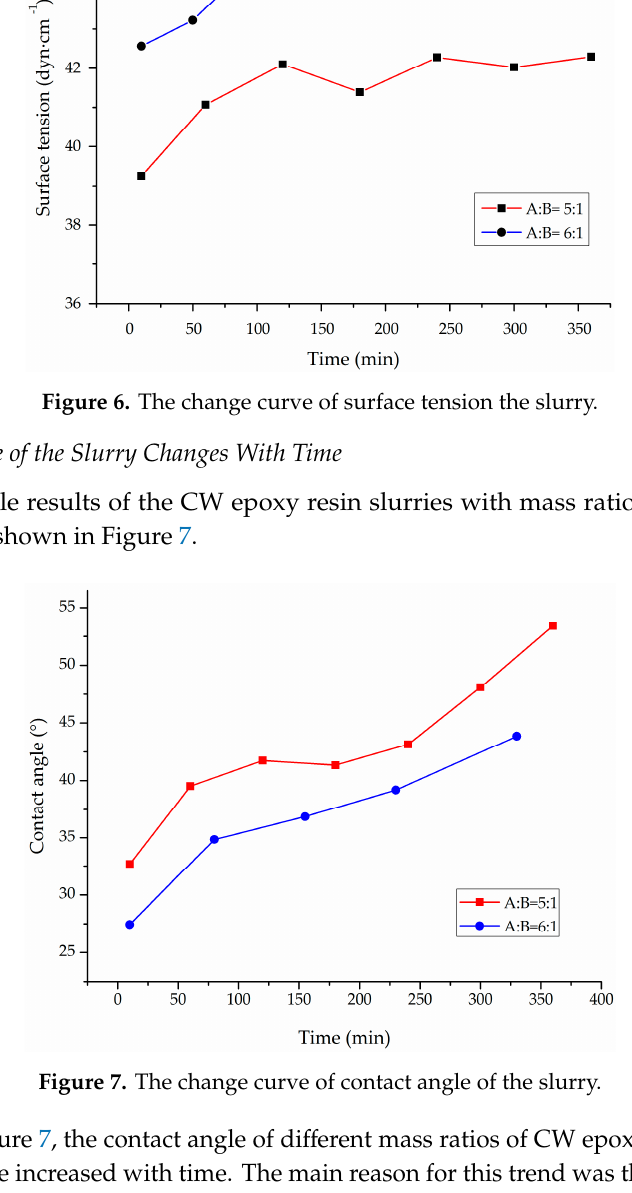
Figure 6. The change curve of surface tension the slurry.